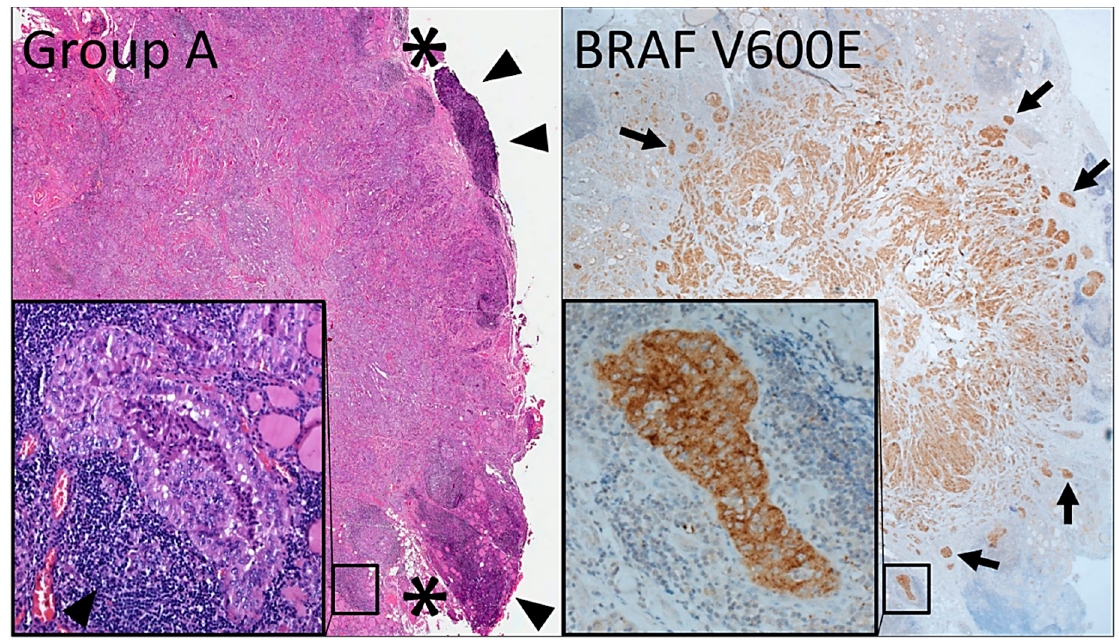
Figure 6. Histologic appearance (hematoxylin and eosin section, H&E) of group A microcarcinomas (left image and inset). This subcapsular tumor measures 9 mm, shows extrathyroidal extension (asterisks), is associated with conspicuous periperitumoral lymphoid cell infiltration (triangles), is of the tall cell histotype (left inset), and carries the BRAF V600E mutation. A serial section of the H&E is immunostained with a BRAF V600E-specific antibody (clone VE1) (right image and inset) to highlight the infiltrative nature of the tumor and intraglandular tumor spread (neoplastic cell aggregates separated from the tumor mass by non-neoplastic thyroid; inset and arrows).